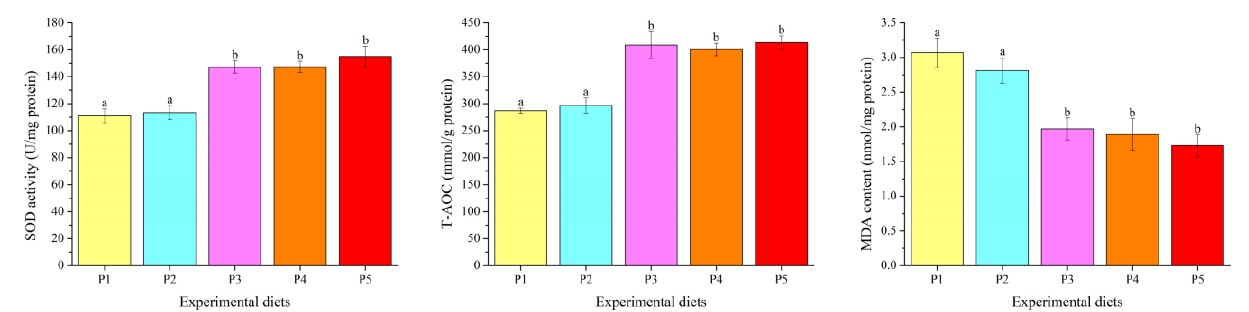
Figure 1. Hepatic antioxidant capacity of Oncorhynchus mykiss fed diets with different protein levels. Values are presented as mean ± SE, n = 4. The small letters indicate significant differences at p < 0.05. SOD: ANOVA, 0.000; linear, 0.000; quadratic, 0.000. T-AOC: ANOVA, 0.000; linear, 0.000; quadratic, 0.000. MDA: ANOVA, 0.000; linear, 0.000; quadratic, 0.000.